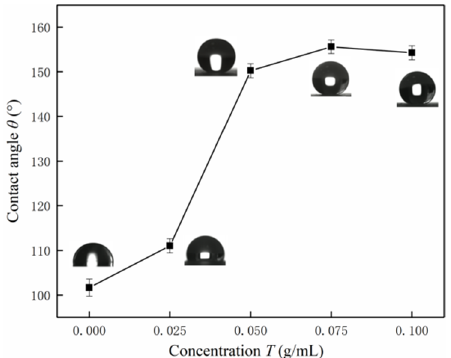
Figure 4. Contact angle data of different concentrations of SiO 2 coatings sprayed.